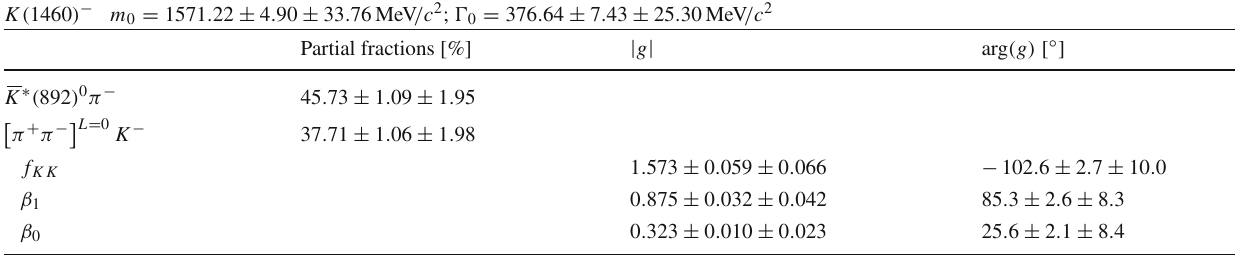
Table 22 Table of fit fractions and coupling parameters for the com- ponent involving the K ( 1460 ) − meson, from the fit performed on the RS decay D 0 → K − π + π + π − . The coupling parameters are defined